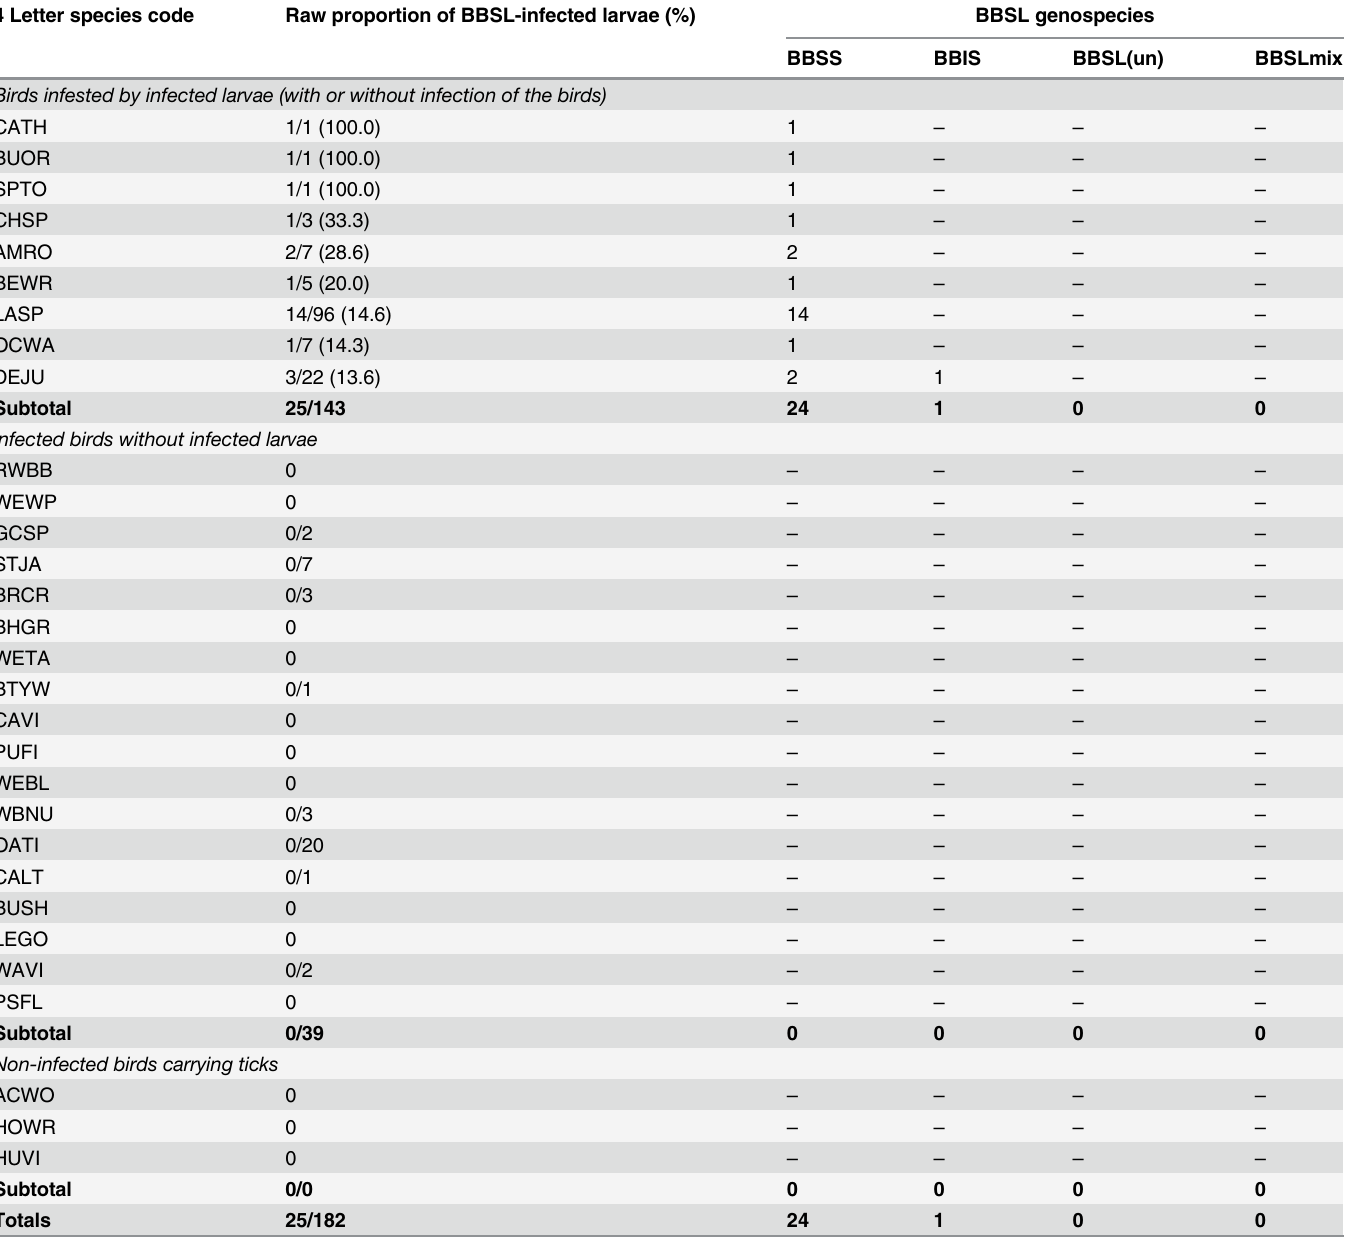
Table 6. Summary of B . burgdorferi s.l. genospecies found in I . paci fi cus larvae removed from birds.